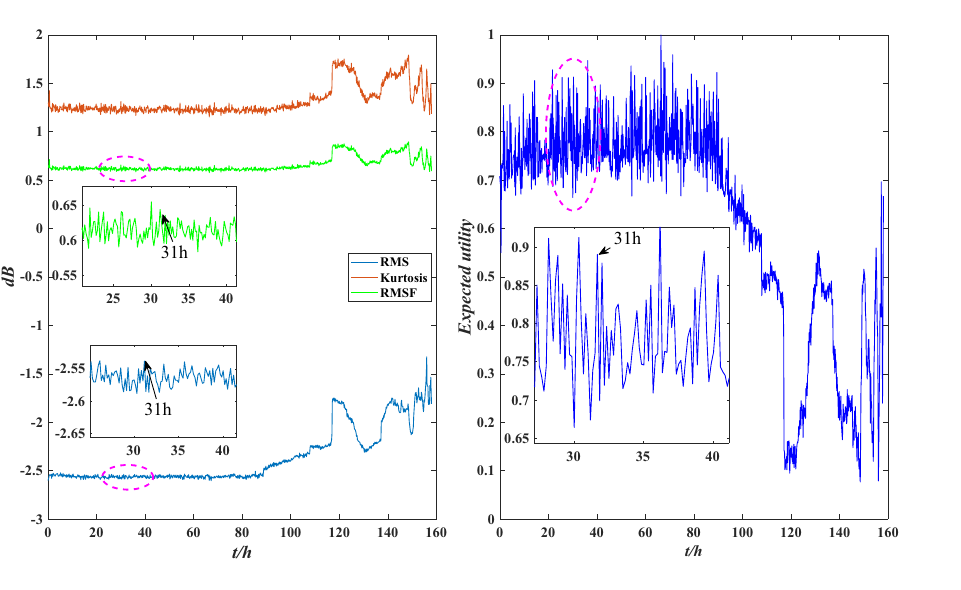
Figure 19. Local indicators and utility